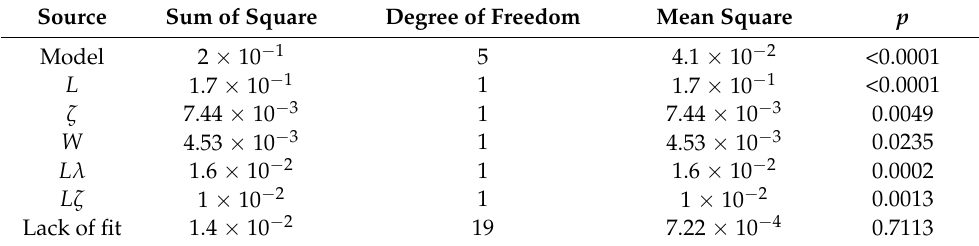
Table 7. Final significance analysis results of model Φ F